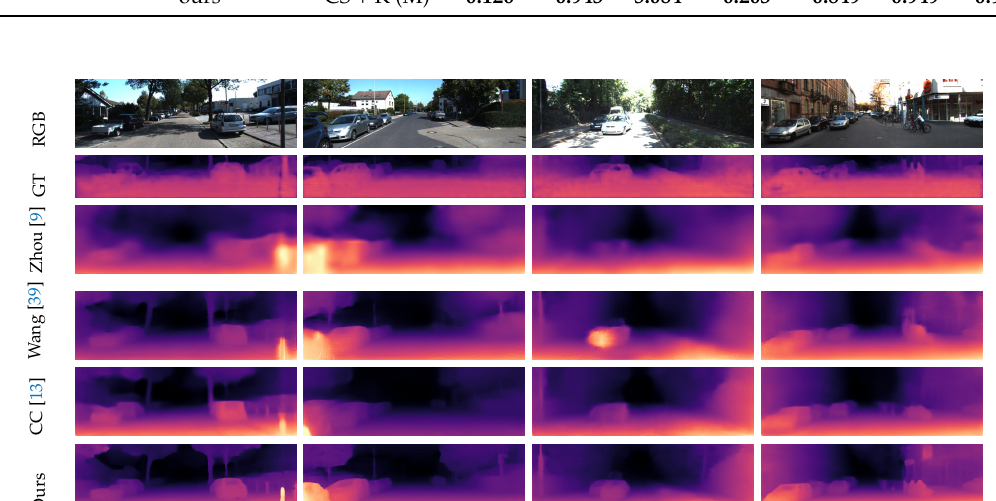
Figure 6. Qualitative results of scene depth estimation on KITTI raw dataset. Compared to other methods, our method has clearer outline and more details in estimated depth map. This can be credited to the use of geometric information in our